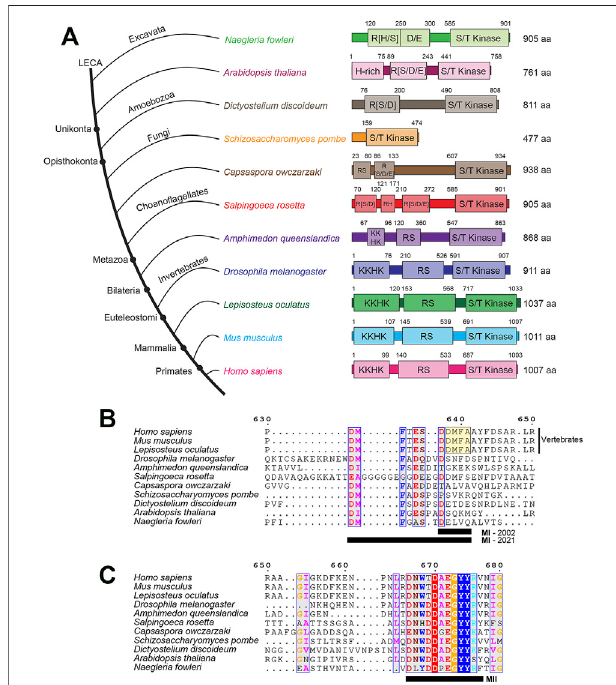
FIGURE 1 | The conserved domain architecture of PRP4K orthologs in representative eukaryotes. (A) PRP4K is highly conserved in different eukaryote clades, with orthologs present in representative species of Bikonta ( Naegleria fl oweri and Arabidopsis thaliana ) and Unikonta ( Dictyostelium discoideum , Schizosaccharomyces pombe , Capsaspora owczarzaki , Salpingoeca rosetta , Amphimedon queenslandica , Drosophila melanogaster , Lepisosteusoculatus , Musmusculus ,and Homosapiens )(Dellaireetal., 2002). Representative species are shown in the consensus cladogram showing the topology (branch lengths are not intended to describe phylogenetic relationships) (Longhorn et al., 2007; Rodríguez-Ezpeleta et al., 2007; Schierwater et al., 2009; Fritz-Laylin et al., 2010). Domains were predicted using InterPro, with sequence positions presented above the domain (Blum et al., 2021). The kinase domain (shown as S/T kinase, Serine/Threonine kinase) was annotated via InterPro. Whereas, the disordered regions (shown as H-rich, Histidine-rich; KKHK, lysine- histidinerepeats;RS,arginine-serinerepeats;R[S/D/E],argininerepeats adjacent to serine, aspartate, and glutamate; R [D], arginine-aspartate repeats) were annotated via MobiDB Lite (Necci et al., 2017). Protein sizesforeachorthologarelistedintermsofaminoacidlengthtotheright of the domain architectures. MUSCLE alignments were performed on PRP4K ortholog sequences (excluding Arabidopsisthaliana )to describe the (B) MI and (C) MII motifs (residues are underlined, black bar) fi rst described by Dellaire et al., 2002. The alignments were visualized using ESPript 3.0 (Robert & Gouet, 2014) and coloured residues indicate different functional groups that are conserved. Dashes indicate gaps within the sequence alignment between orthologs. Positions for the alignment correspond to the human PRP4K protein sequence. Note, that the original MI motif (yellow boxed sequence DDMFA, MI-2002) described by Dellaire and colleagues has been expanded to include a larger conserved motif apparent when additional PRP4K orthologs are taken into account